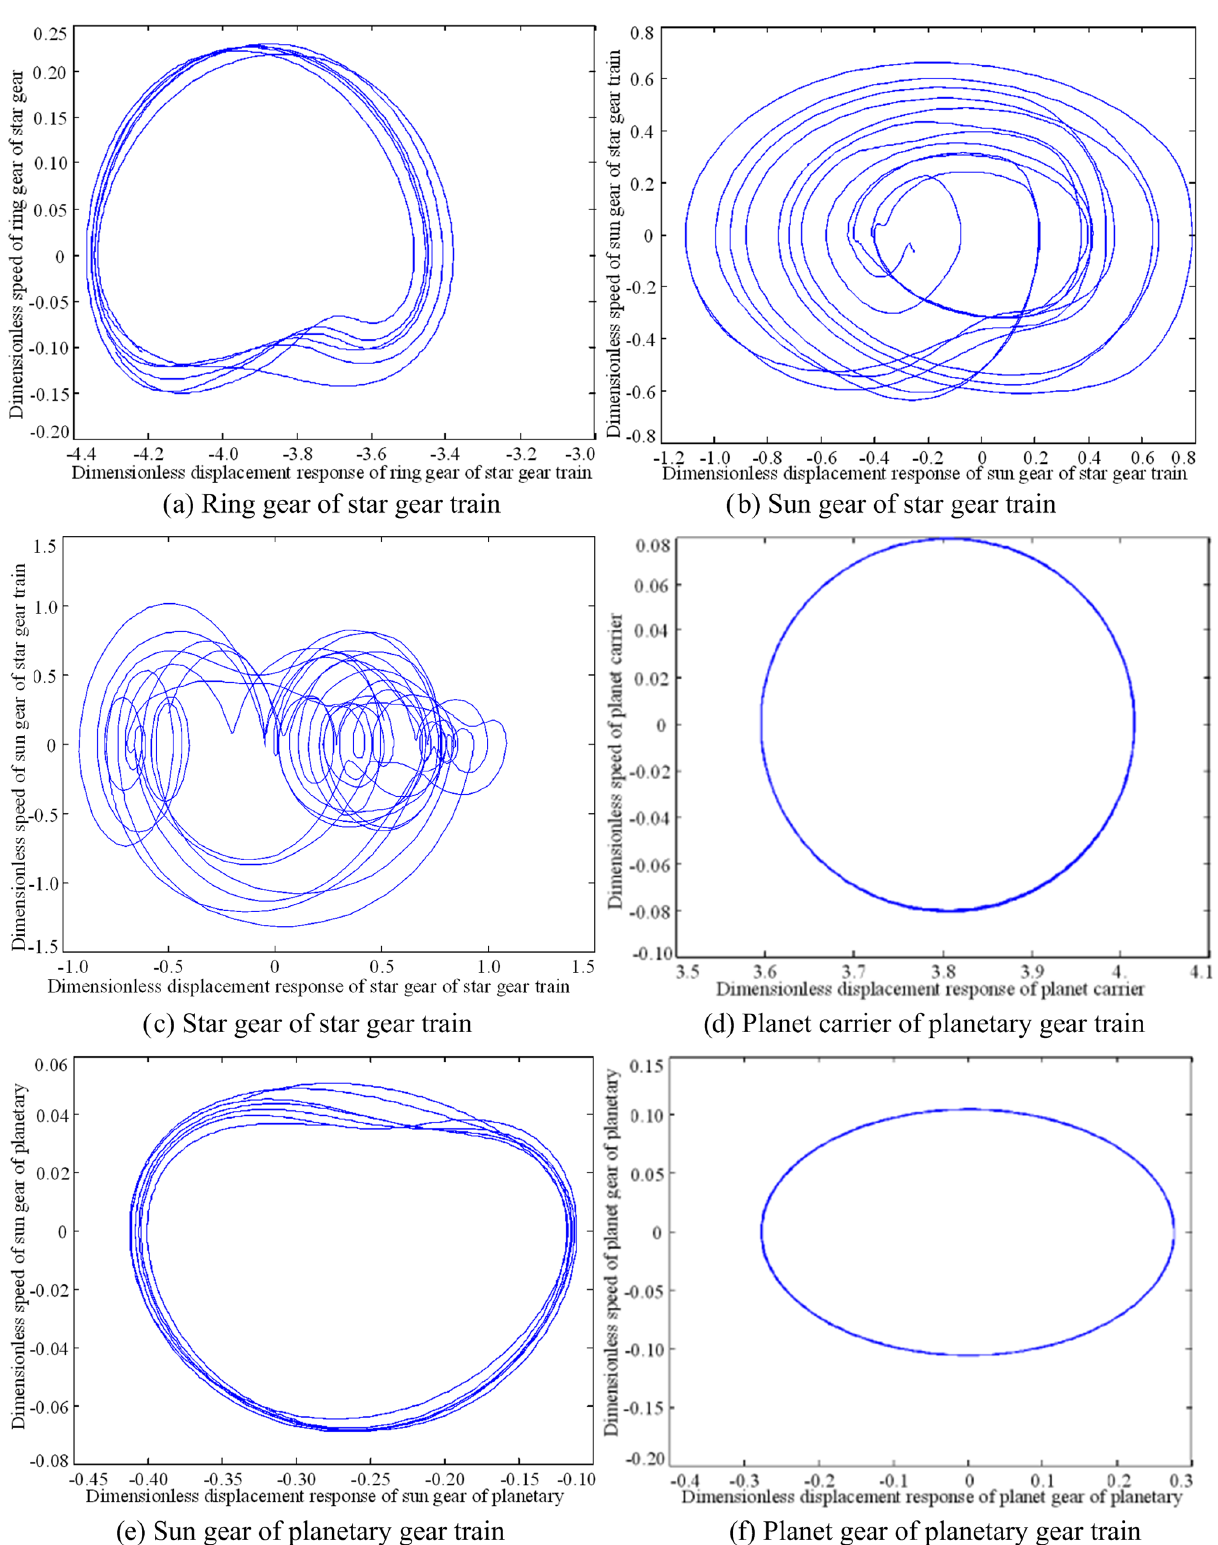
Figure 7. Phase plan of the composite transmission